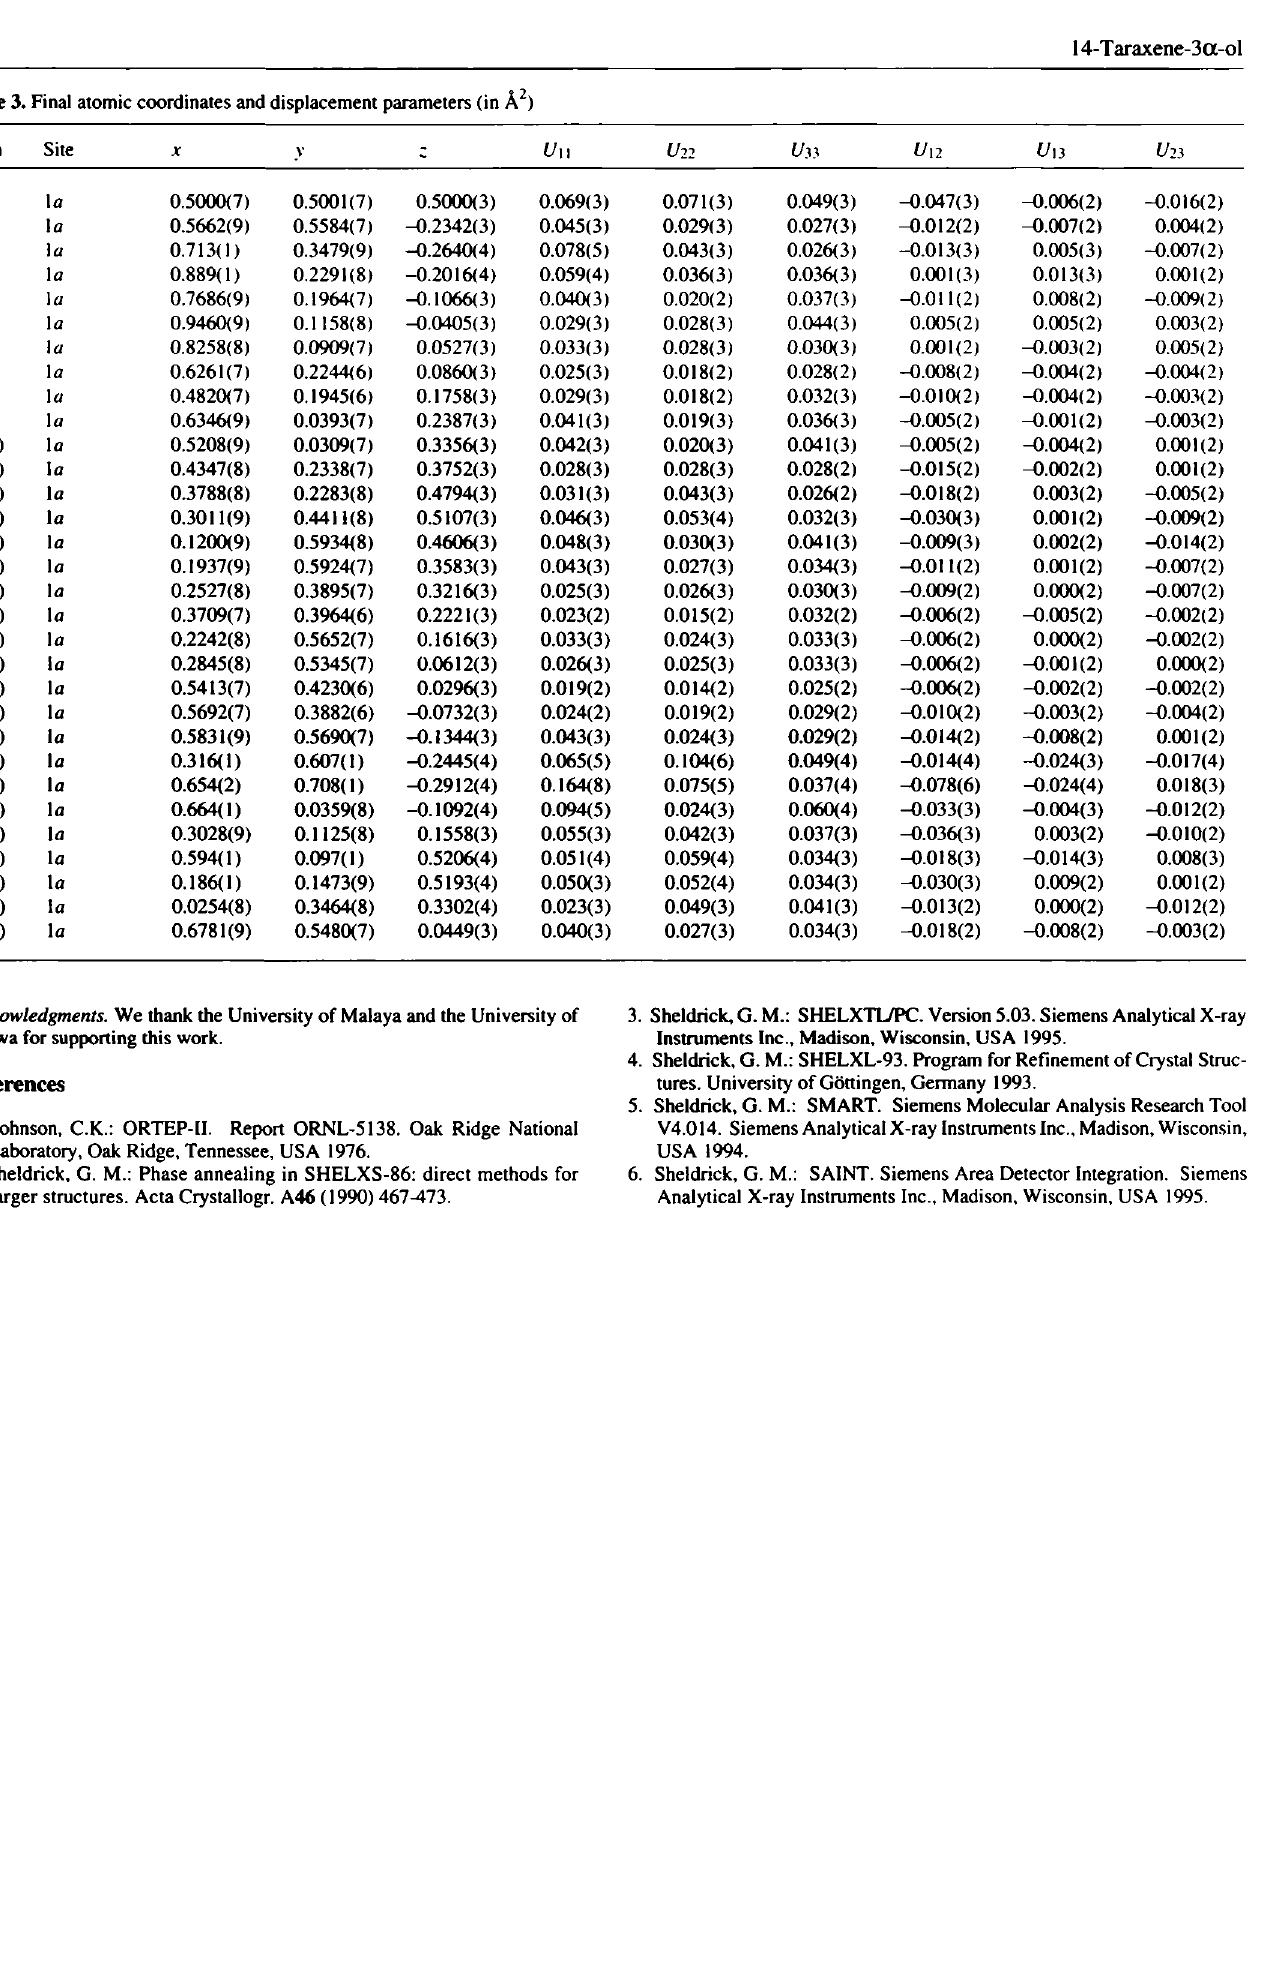
Table 3. Final atomic coordinates and displacement parameters (in